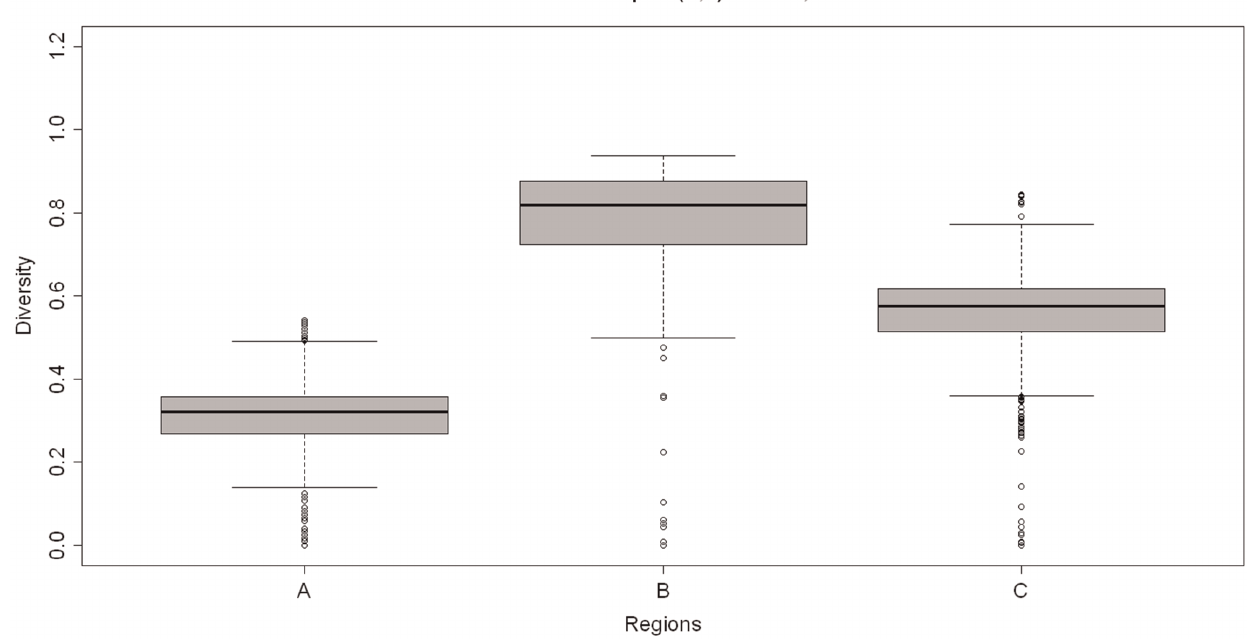
Figure 2. The disordered regions of OVOL have evolved more rapidly than structured regions. A) Structured regions only, B) Disordered segments only, C) Full-length